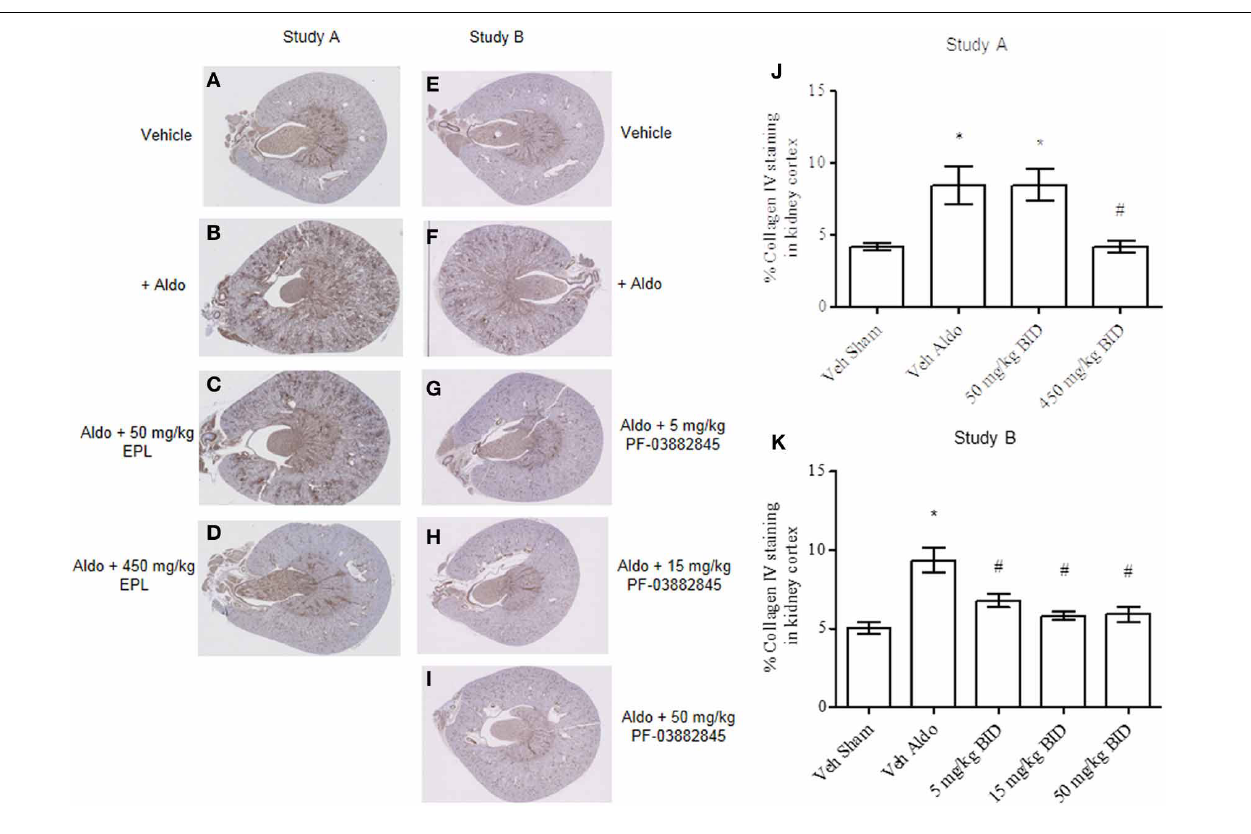
FIGURE 6 | Representative images of collagen IV immunohistochemical localization in kidney cortex. Study A, vehicle sham (A) , vehicle + aldosterone (B) , 50mg/kg BID eplerenone (C) , and 450mg/kg BID eplerenone (D) , groups following 27 days of treatment; and Study B, kidney cortex from sham vehicle (E) , vehicle + aldosterone (F) , 5mg/kg BID PF-03882845 (G) , 15mg/kg BID PF-03882845 (H) , and 50mg/kg BID